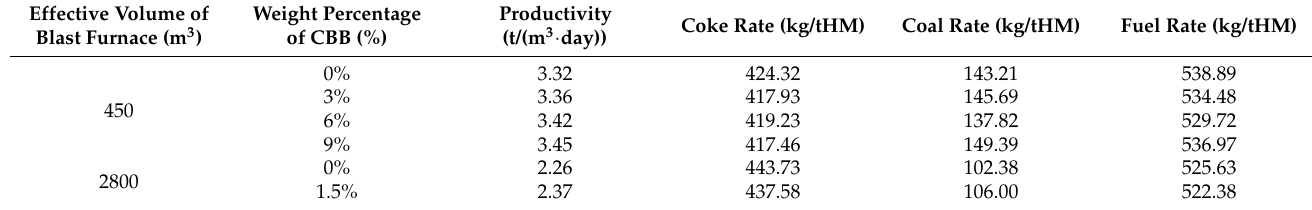
Table 4. Effect of return fines of CBBs on the performance of two blast furnaces with different ef ‐ fective